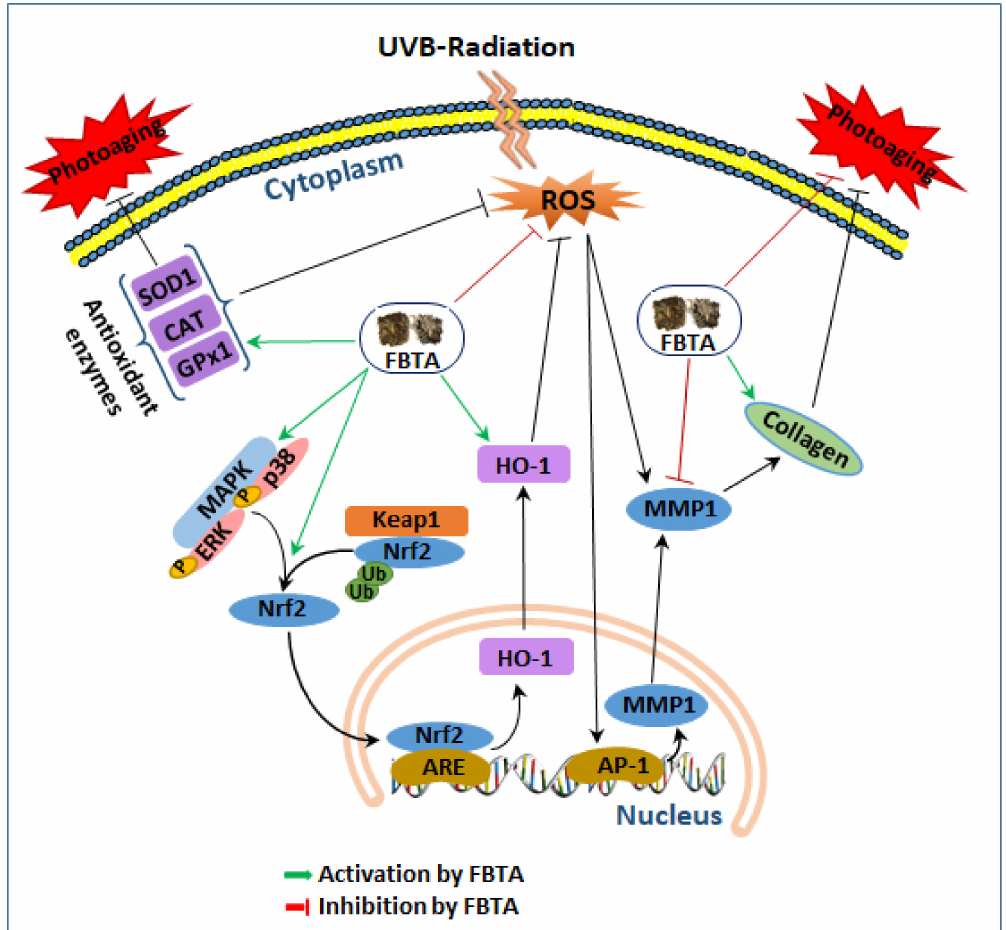
Figure 8. A proposed anti-aging mechanism of FBTA in the UVB-induced photoaging human keratinocytes. Ub, ubiquitin; ARE, antioxidant response element. Green arrows, activation by FBTA; red bars, inhibition by FBTA, black arrows, activation; black bar, inhibition.